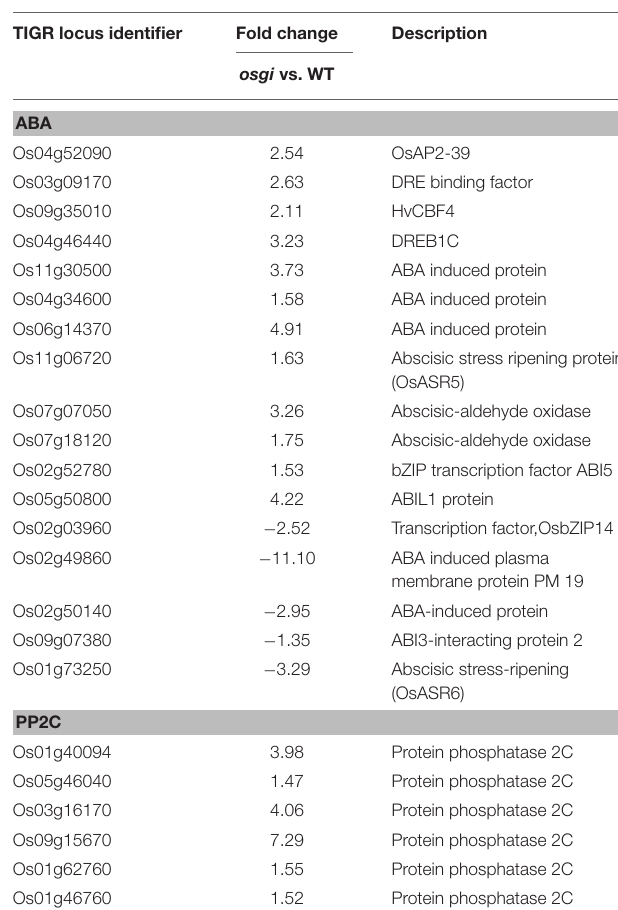
TABLE 1 | ABA signaling-related genes with significantly altered transcript abundance in osgi compared to WT leaves ( p <